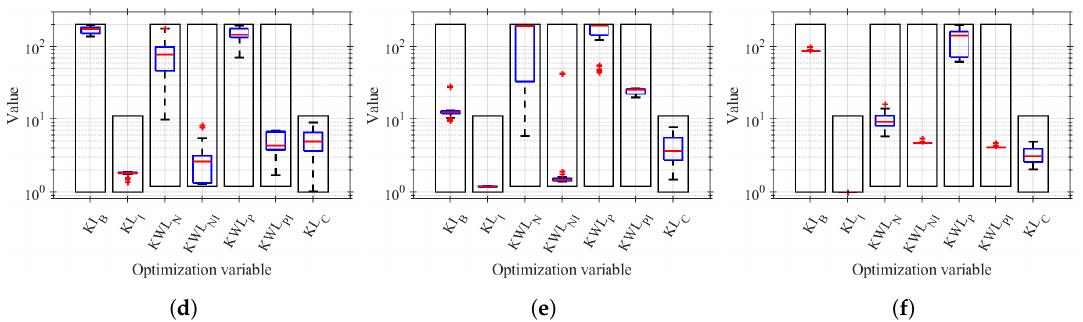
Figure 15. Values of the optimization variables of the solutions in the Pareto front obtained with: ( a ) SQP-180 nm, ( b ) SQP-130 nm, ( c ) SQP-65 nm, ( d ) NSGA-II-180 nm, ( e ) NSGA-II-130 nm and ( f ) NSGA-II-65 nm.